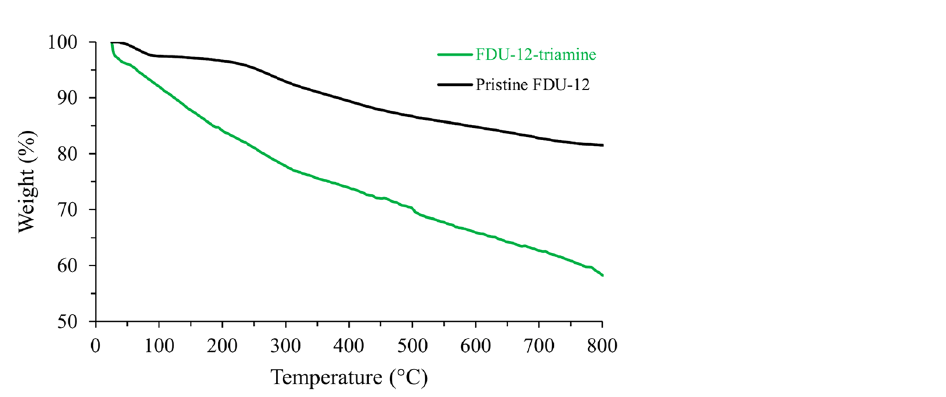
Figure 4. N 2 adsorption/desorption isotherms of (a) pristine FDU-12, (b) FDU-12-methacrylate, and (c) FDU- 12-triamine. The BJH pore size distribution curves of the samples are also shown.